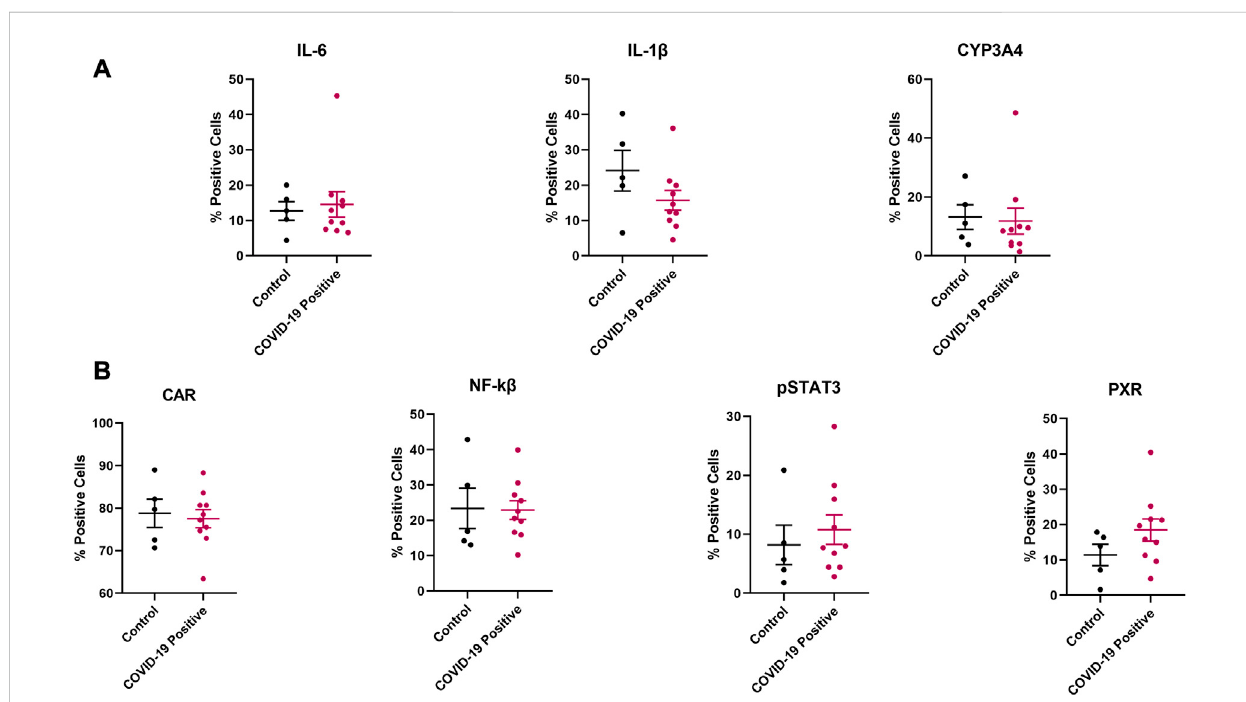
FIGURE 5 EffectofCOVID-19ontheproteinexpressionofselected (A) in fl ammatorymarkersandCYP3A4, (B) regulatoryproteinsinpostmortemhumanlung tissues.ChromogenicimagesobtainedfromtheimmunostainedtissueslidesfromeachsubjectwereanalyzedusingHALOsoftwarev3.4(IndicaLabs)for absolute quantitative IHC analysis. Results are expressed as mean ± SEM, and the non-parametric two-tailed Mann-Whitney test was used to determine the differences in protein expression between COVID-19 and control postmortem human lung tissues for absolute quantitative IHC